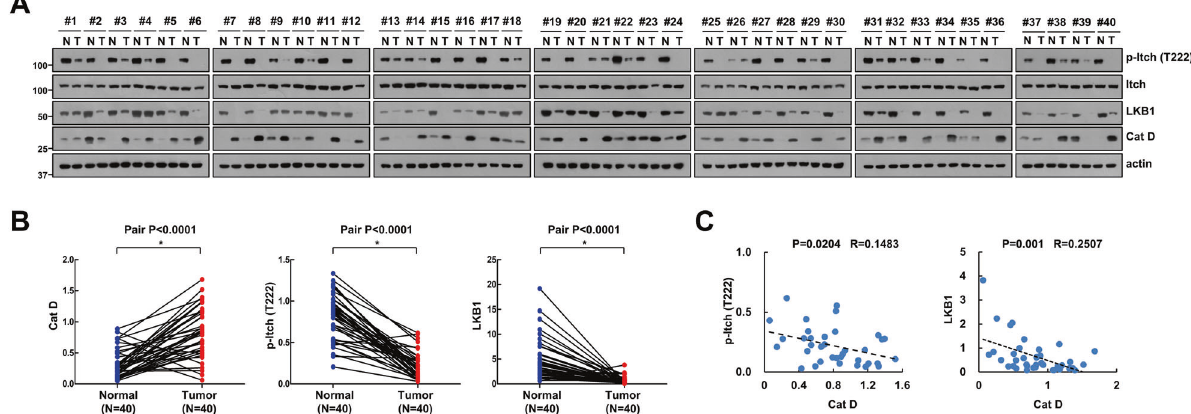
Fig. 7 The inverse correlation between Cat D and phospho-Itch or LKB1 expression in renal tumor tissues. A , B Analysis of protein expression in 40 paired primary renal clear carcinoma tissues as compared with the adjacent normal tissues. C The inverse correlation between Cat D and phospho-Itch or LKB1 was observed at the protein levels.